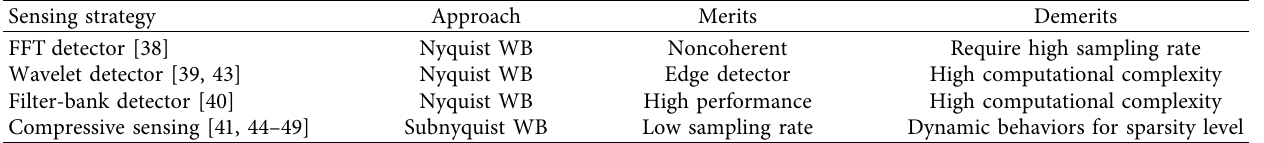
Table 3: Performance comparison of wide band spectrum sensing models.